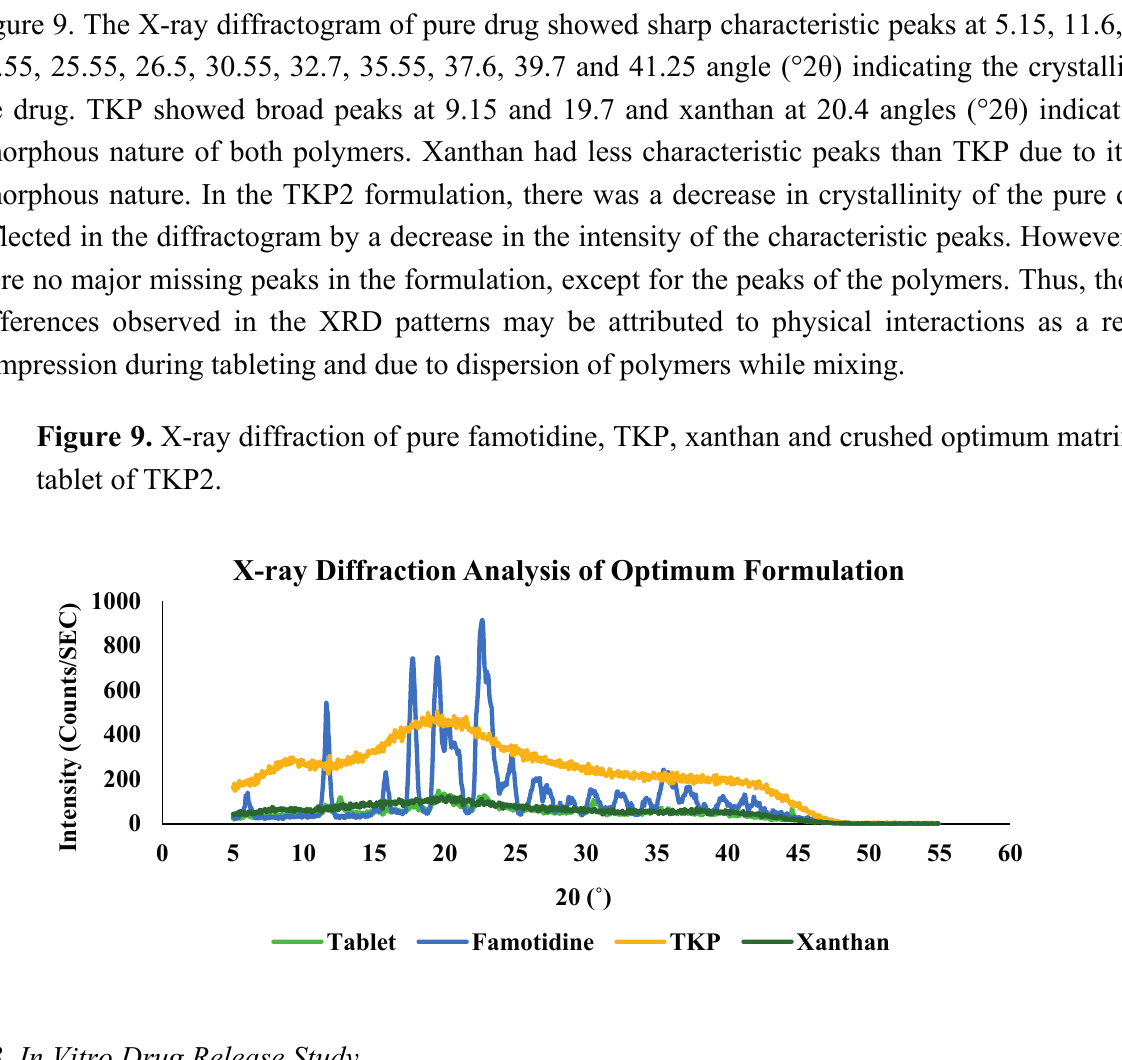
Figure 9. The X-ray diffractogram of pure drug showed sharp characteristic peaks at 5.15, 11.6, 17.65,